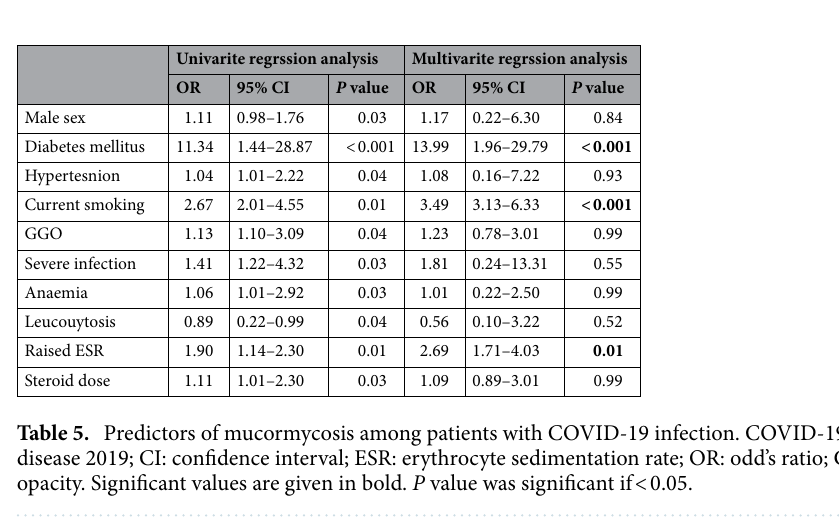
Table 4. Presentation and neurological manifestations among patients with mucormycosis. Data expressed as frequency (percentage).